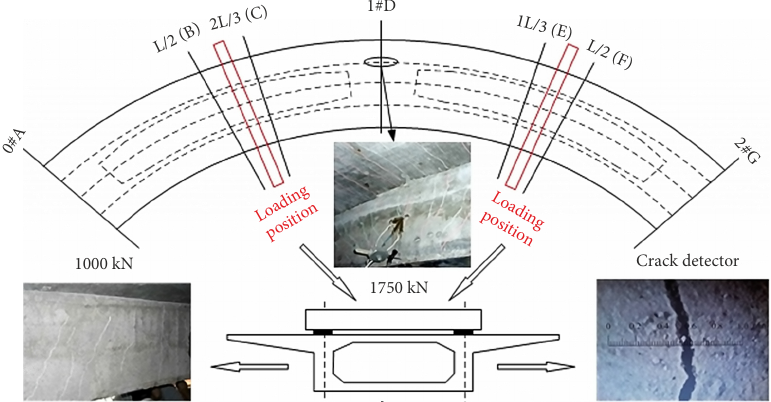
Figure 3. The loading positions and the crack profile of key locations